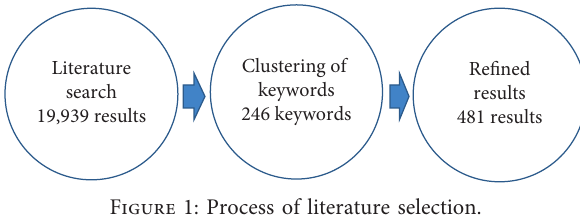
Figure 1: Process of literature